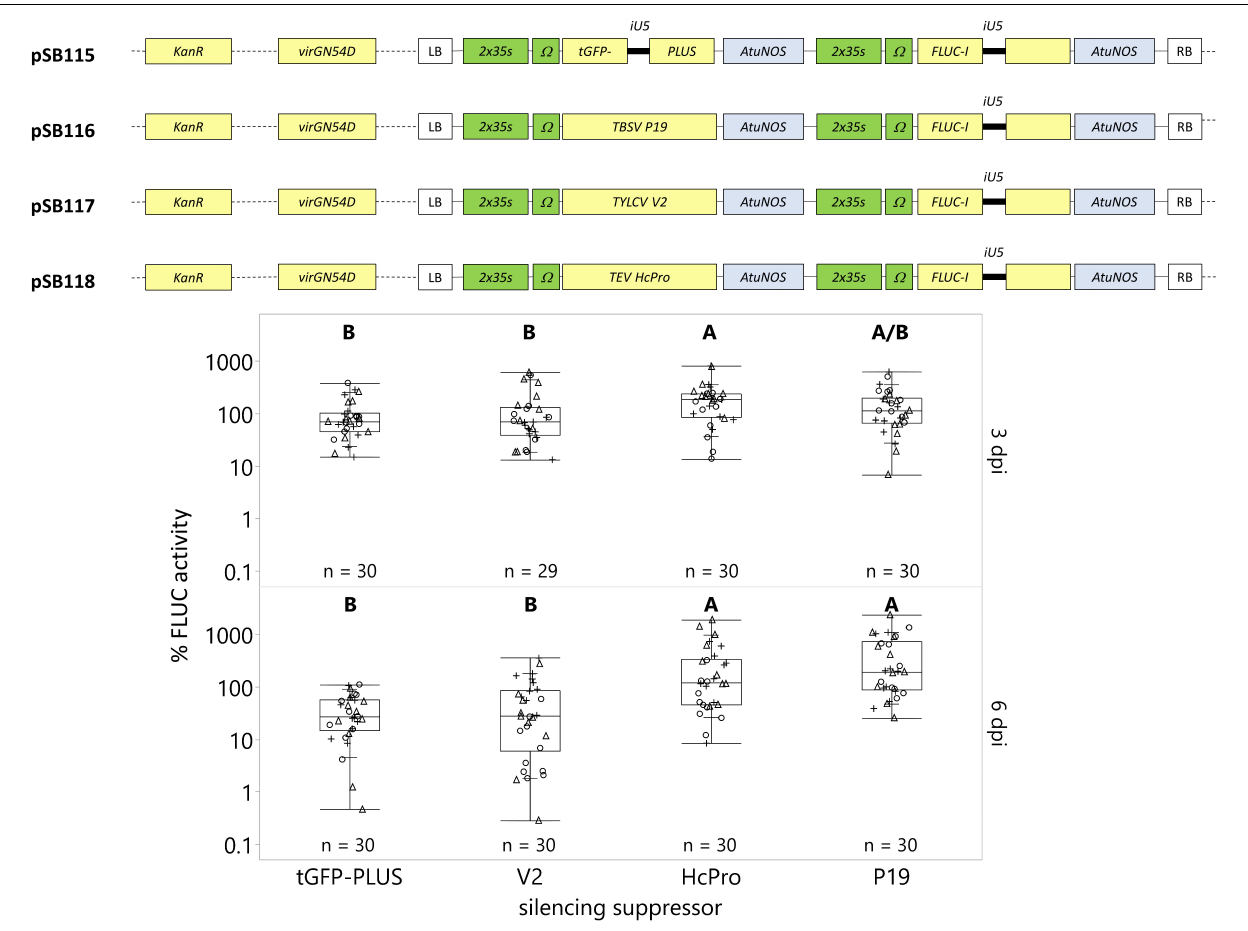
FIGURE 5 | The silencing suppressors HcPro and P19 enhance transgene expression with prolonged cultivation post-infection. C. roseus seedlings (10-days-old) were vacuum infiltrated with A. tumefaciens containing the FLUC-I reporter and silencing suppressor within the same plasmid (TYLCV V2 – pSB117, TEV HcPro – pSB118, TBSV P19 – pSB116) or control (tGFP-PLUS – pSB115) at OD 600 = 0.2. Samples were taken at 3 and 6 dpi. FLUC activity was normalized to protein content. The average FLUC activity to protein content of control samples (tGFP-PLUS) collected 3 dpi was used as reference (set to 100%) to determine the relative FLUC activity of each sample. The experiment was carried out in three independent assays (represented by the + , (cid:13) , (cid:49) symbols). The box plot horizontal line shows the median, ends of the boxes show interquartile range, small marks show the 10th and 90th quantile, and whiskers show lowest/highest data point. Different letters indicate significantly different values within the 3 or 6 dpi groups (Tukey-Kramer HSD test on each group, on log-transformed data, p < 0.05).